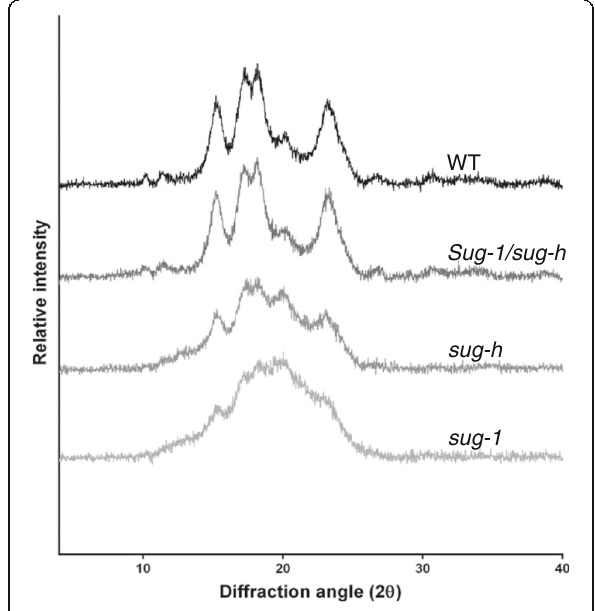
Fig. 2 X-ray diffraction analysis of purified starch granules from mature endosperm of wild-type rice (Hwacheong), sug-1 , sug-h , and Sug-1 / sug-h. The seeds possessed a normal OsISA1 and a mutated osbe2a genotypes were designated as Sug-1 /